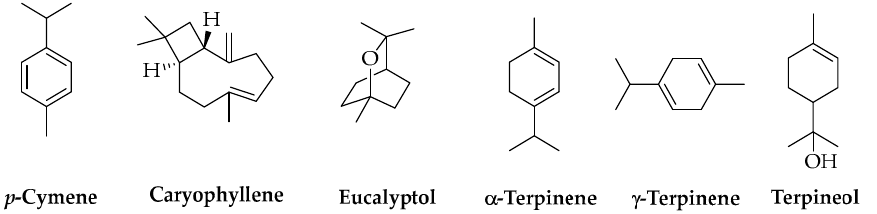
Figure 8. Chemical structures of terpenes.